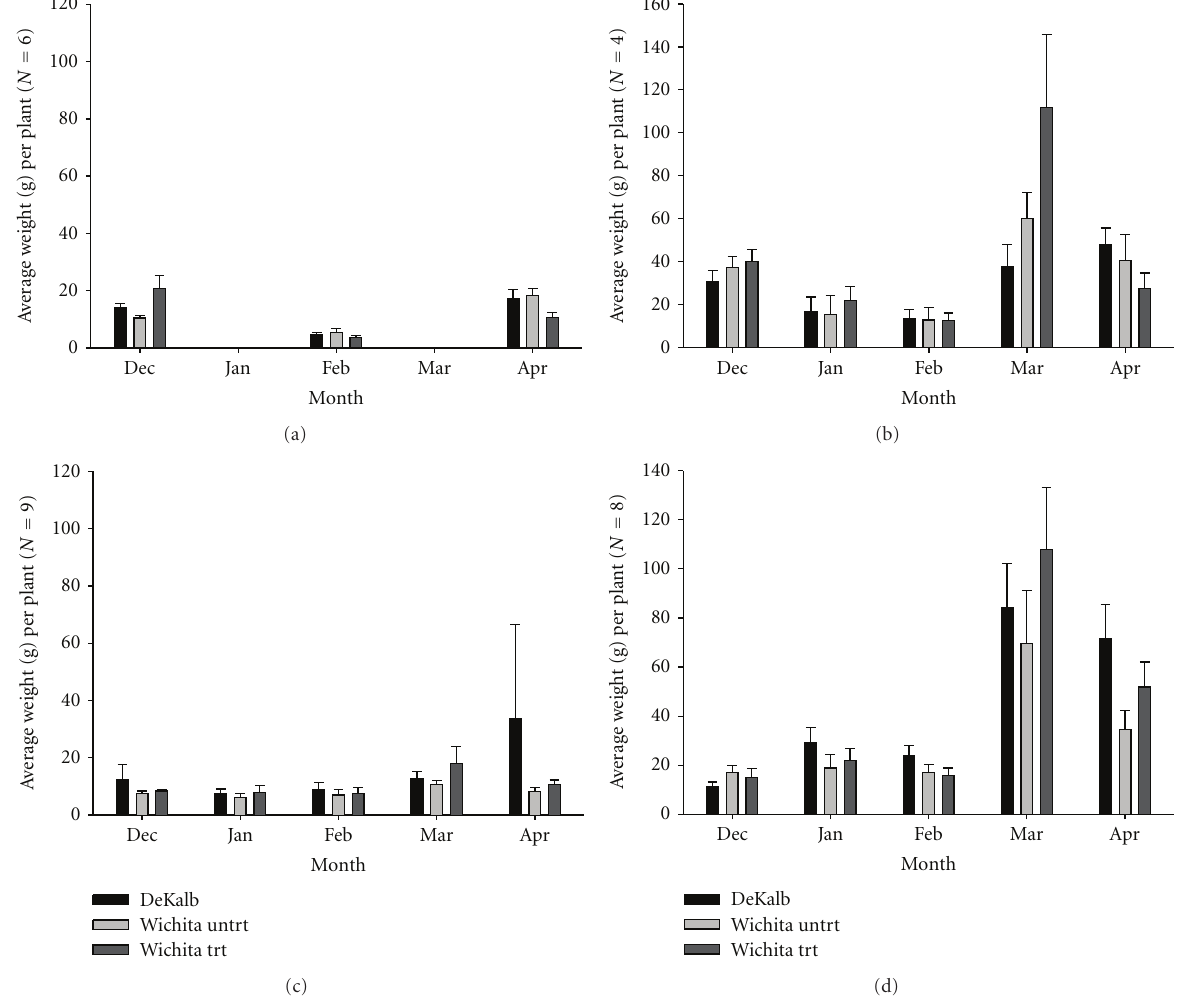
Figure 1: Average monthly canola plant weight (grams) over time at two field locations. Canola plants were sampled from Clovis, NM ((a) and (b)) and Halfway, TX ((c) and (d)) during growing season 1 (2007-2008) ((a) and (c)) and growing season 2 (2008-2009) ((b) and